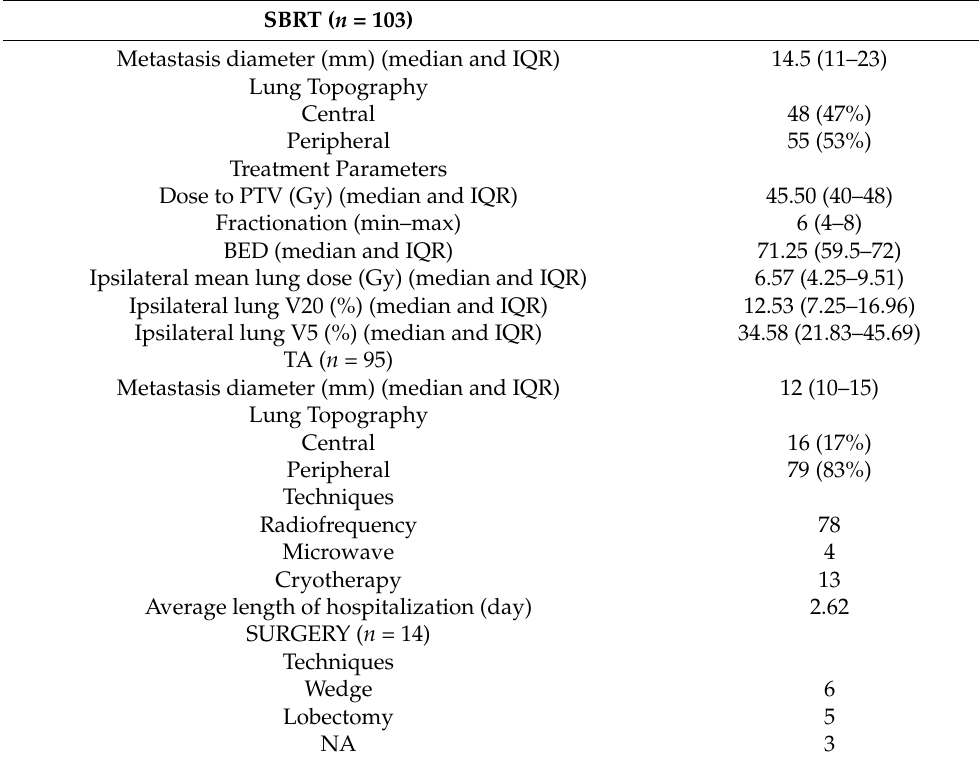
Table 2. Focal treatments